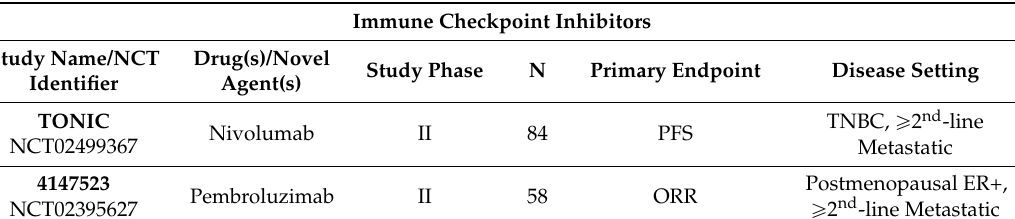
Table 2. Clinical Trials of Immunotherapy in Breast Cancer